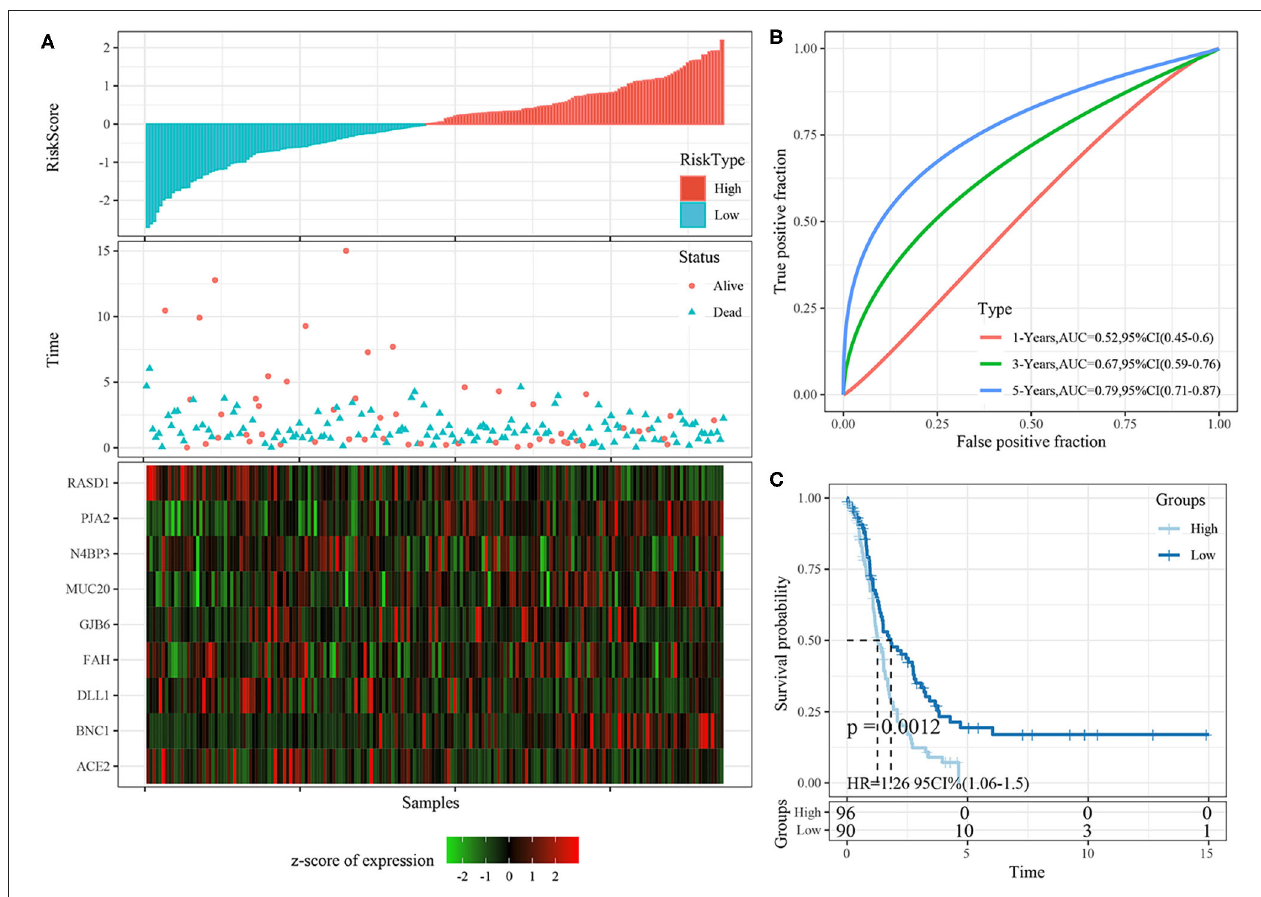
FIGURE 8 | (A) The distribution of risk score, survival time, and the expression of 9-gene in TCGA testing cohort; (B) The ROC curve and AUC curve of 9-gene signature in testing cohort; (C) The KM survival curve of 9-gene signature in testing